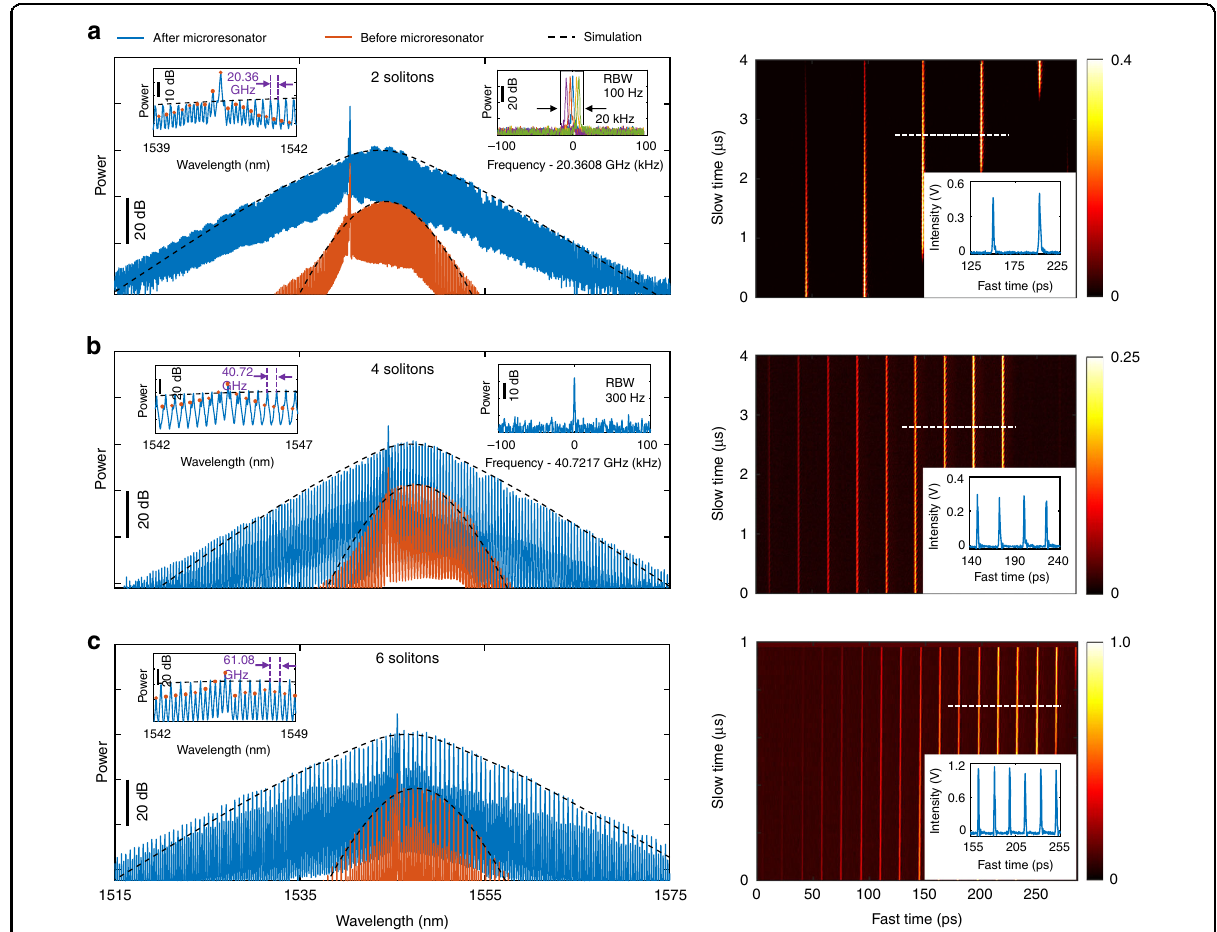
Fig. 3 Experimental generation of perfect soliton crystals. a – c soliton crystal with 2-FSR ( a ), 4-FSR ( b ) and 6-FSR ( c ). Left: optical spectrum. There is an power offset between the spectra before and after the microresonator to clearly show the envelope of the XPM induced combs. Inset: enlarged spectrum and RF beat note of the soliton repetition rate. XPM comb peaks are indicated by orange solid circles. RF beat note of the soliton repetition rate with 60 GHz is not measured due to the lack of commercial electronics (see Methods). Right: real-time evolution of stable soliton recorded by time magni fi er system. Inset: temporal trace calibrated by the responsivity curve. The white dashed line shows the time window of